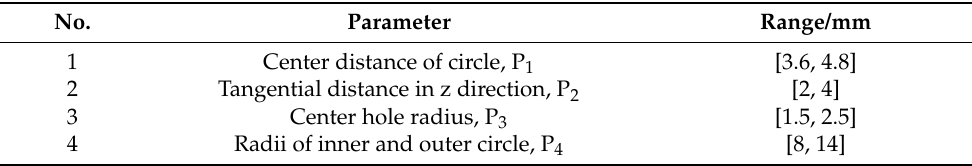
Table 1. Range of structural parameters to be optimized in a bowl-shaped tile.